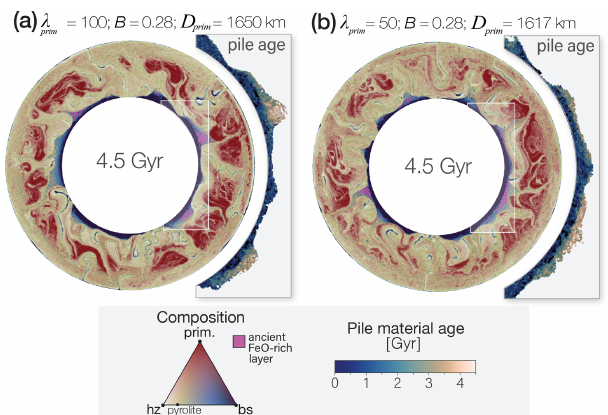
Figure 7. Final snapshots (at 4.5Gyr) of composition for selected models, λ prim and B , as stated in the panels. The models are ini- tialized with a 200km thick FeO-rich basal layer (pink) overlain by a (a) 1546 and (b) 1514km thick primordial layer. The panels also show a zoom-in on the formation age of ROC within the piles (de- fined as f bs > 0 . 6 and T pot > 2000K). The formation age quantifies the time since the last melting